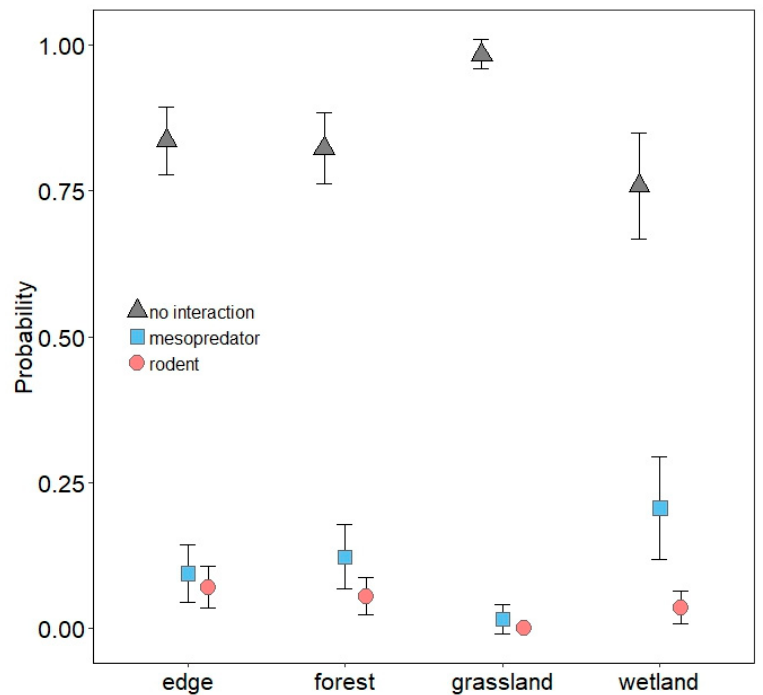
Figure 6. Probability with 85% confidence interval of mesopredators and rodents interacting with three-dimensional printed turtle models (or no interaction) in forest edges, forests, grasslands, and wetlands.